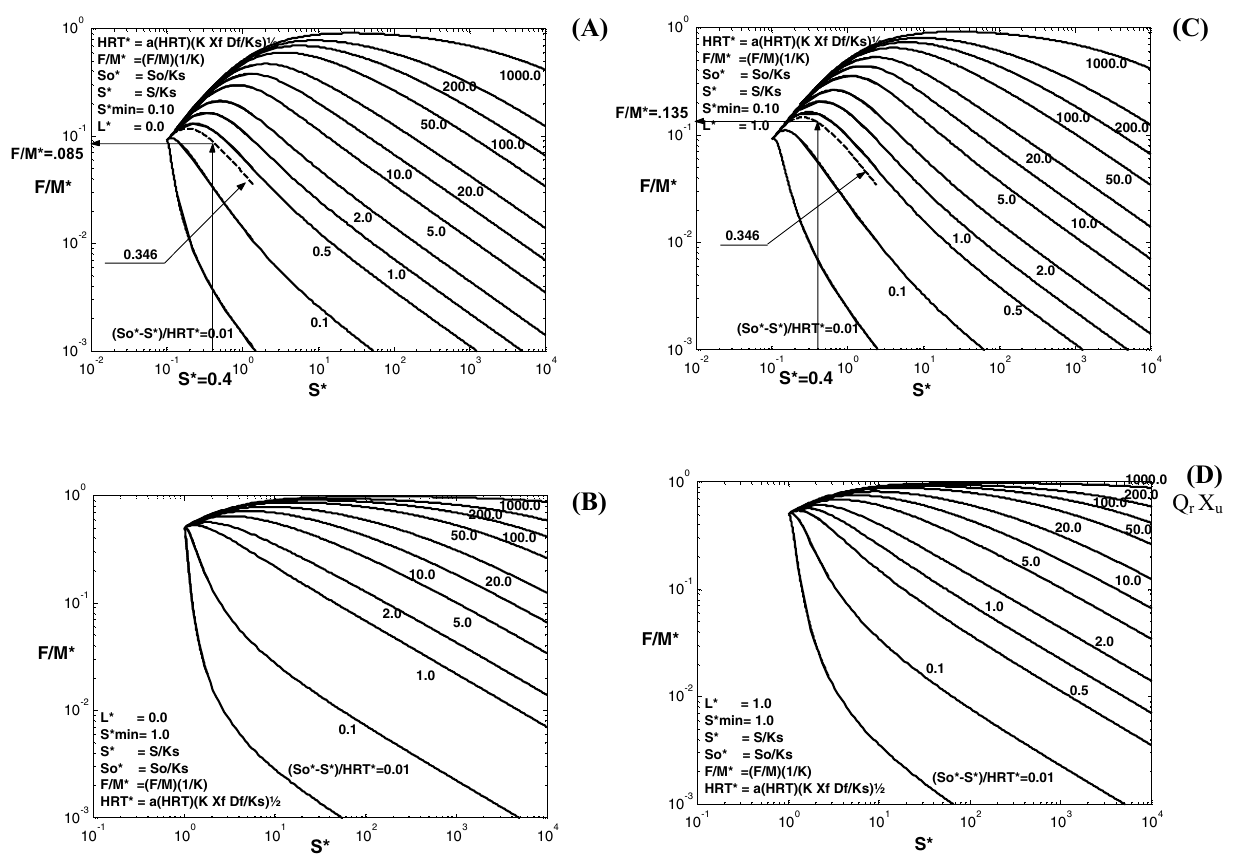
Fig. 7 F / M * as a function of S * and ( S * − S )/HRT at a L * = 0.0, S ∗ min = 0.10, b L * = 0.0, S ∗ min = 1.0, c L * = 1.0, S ∗ min = 0.10 and d L * = 1.0, S ∗ min =